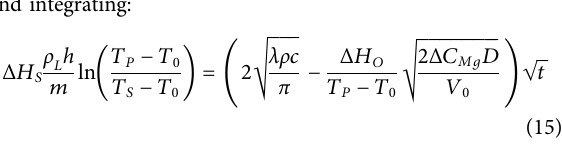
characterized well by a linear function of temperature.